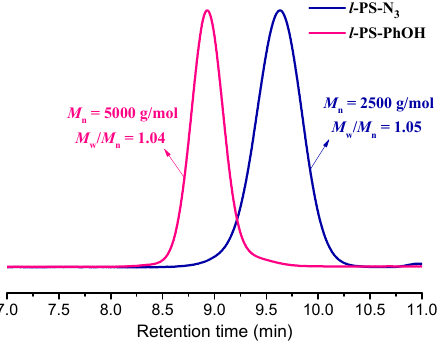
Figure 2. Size exclusion chromatography (SEC) curves of l -PS-N 3 and l -PS-PhOH. Tetrahydrofuran (THF) as the eluent and PS as calibration standards.